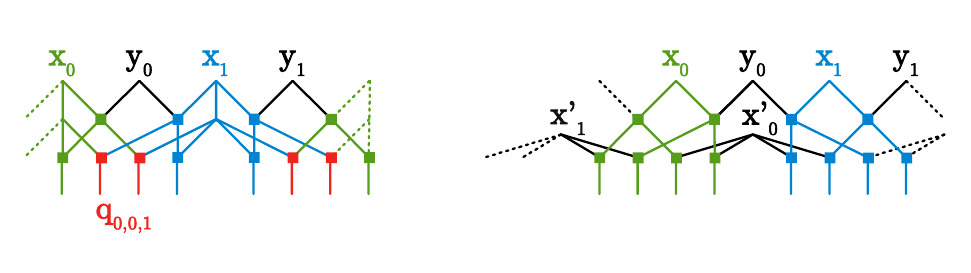
Figure 3: Example for an insecure first-order masked circuit, calculating ( x · y ) · x (left), and a secure circuit ( x · y ) · x 0 (right). The shares of x are colored green ( x for the sake of clarity.